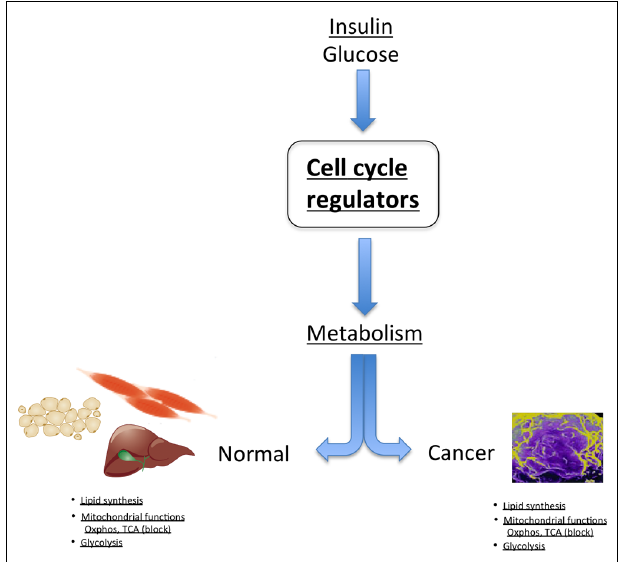
FIGURE 2 | In normal tissue, cell cycle regulators control metabolic processes, such as regulation of lipid synthesis, glycolysis, and modulation of mitochondrial activity. Strikingly, these are the same metabolic pathways that are deregulated in cancer